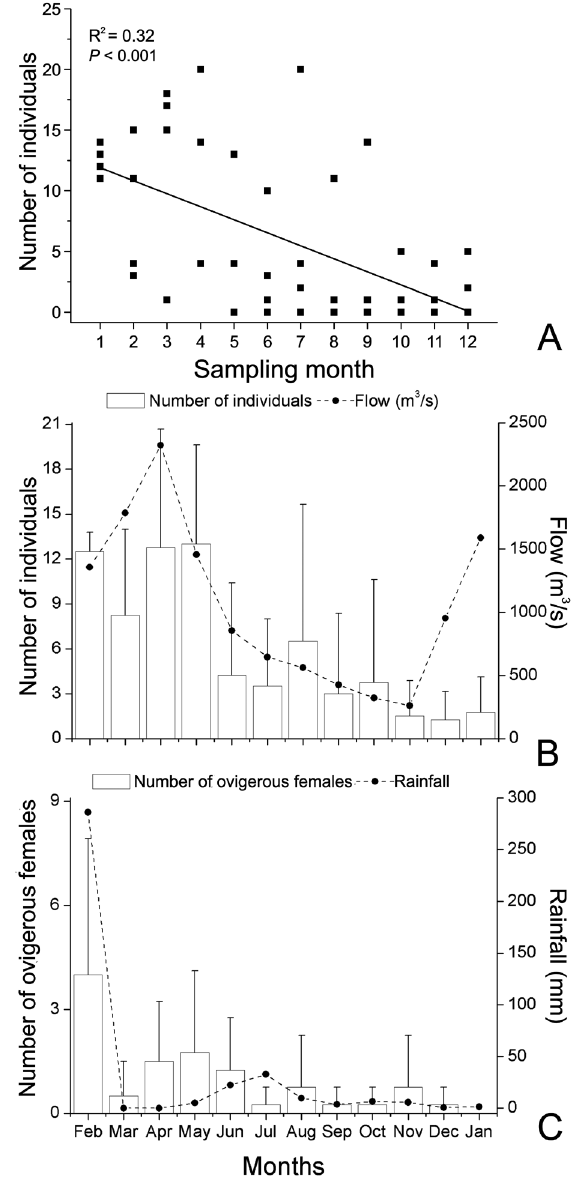
Figure 5. Atya scabra (Leach, 1816). ( A ) Relationship between sampling month and number of individuals; ( B ) monthly variation in the number of individuals (average ± SD) and mean flow (m 3 /s) and ( C ) monthly variation in number of ovigerous females (average ± SD) and mean rainfall (mm) during the sampling